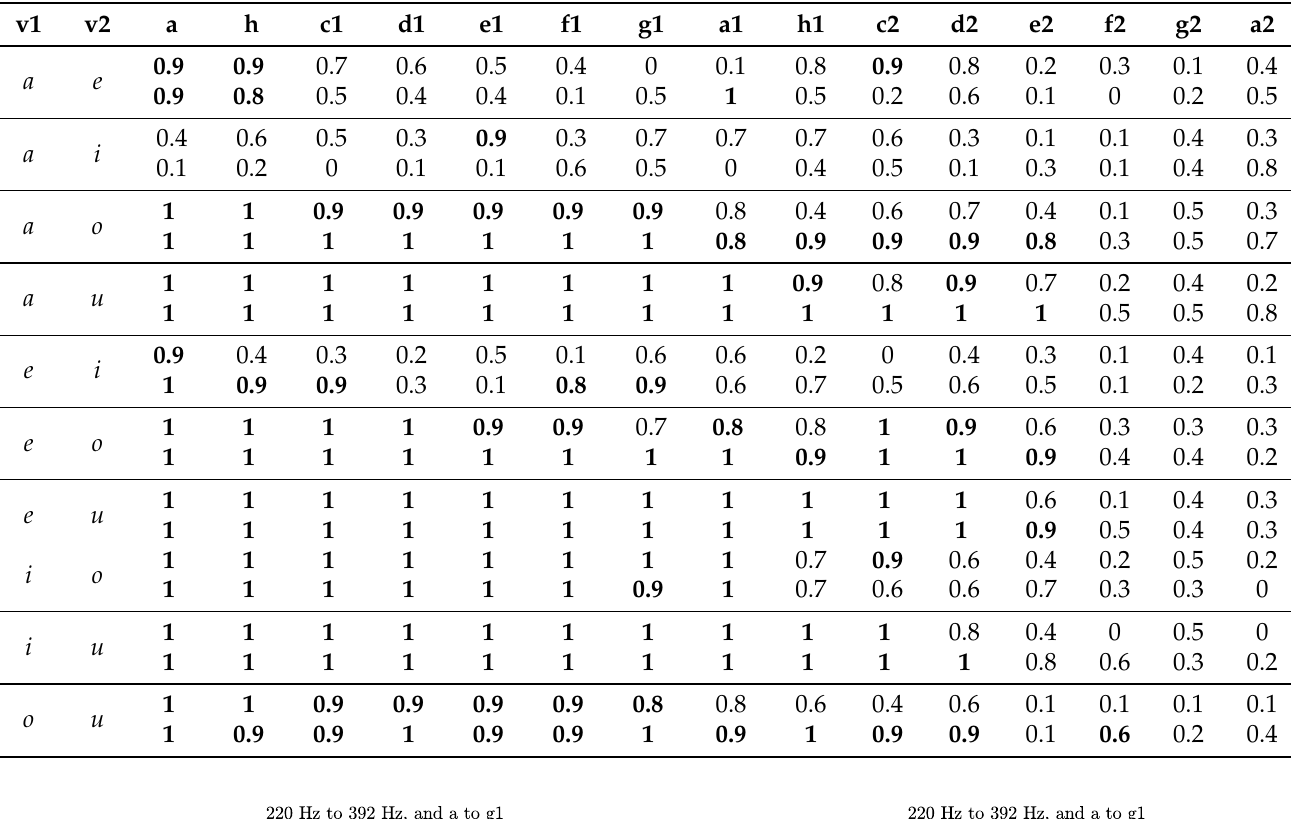
Table A1. Biserial correlation coefficients for the horizontal and vertical beamwidths at each pitch for the female singers (samples n = 18). Horizontal and vertical biserial correlation coefficients are listed at the top and bottom in each cell. Bold letters indicate that there is a significant difference ( p > 0.05) between the vowel groups listed in the first and second